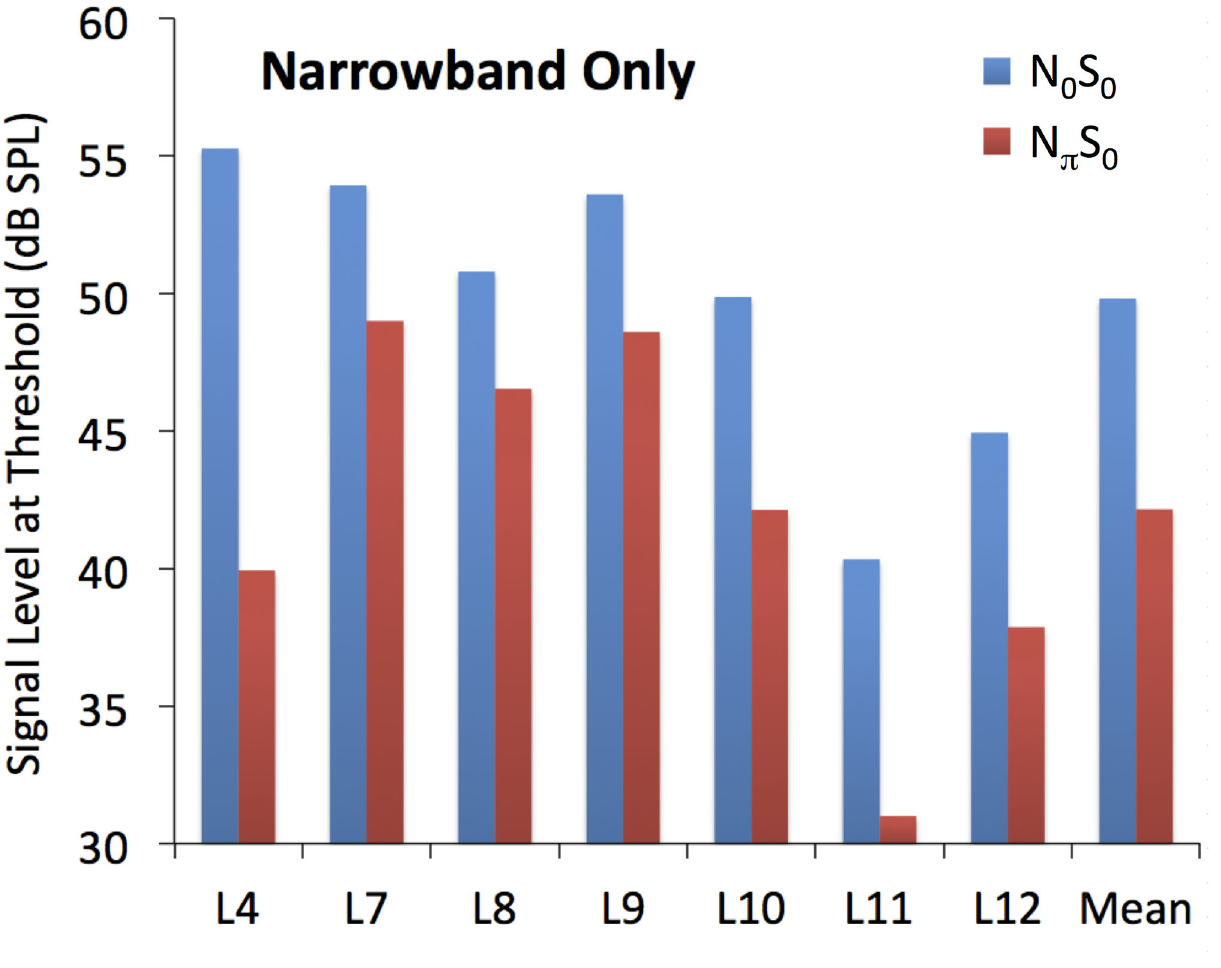
Figure 3. The individual and mean results of the second experiment. Signal thresholds for the N shown by the blue and red bars